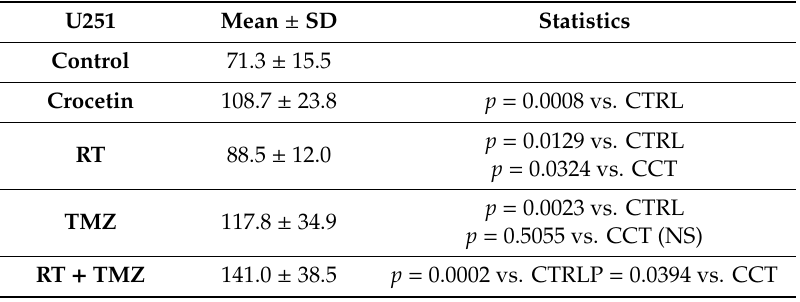
Table 5. Summarized statistical data of overall survival times, as analyzed in Figure 6C.